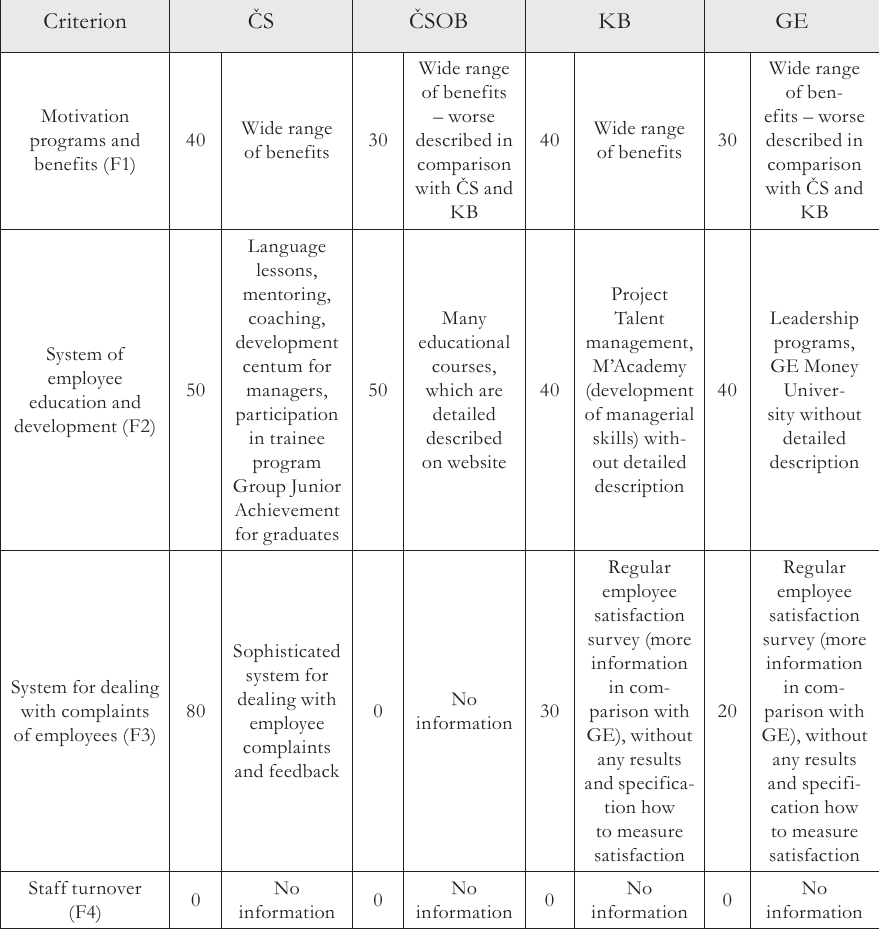
Tab. 6 - Evaluation criteria in the area of the Employment. Source: